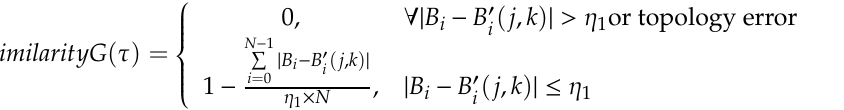
Figure 6. Mapping from a local subgroup of the road network to chromosome.